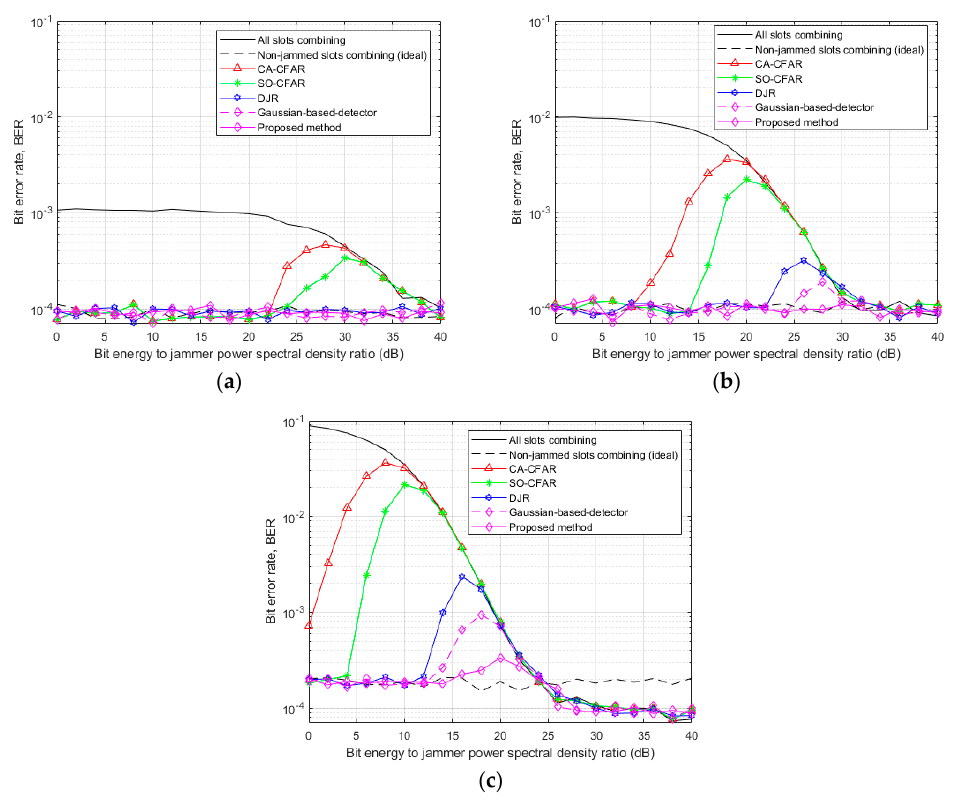
Figure 6. Bit-error-rate (BER) performance: ( a ) 𝜌 = 0.0005 , ( b ) 𝜌 = 0.005 , ( c ) 𝜌 = 0.05 .